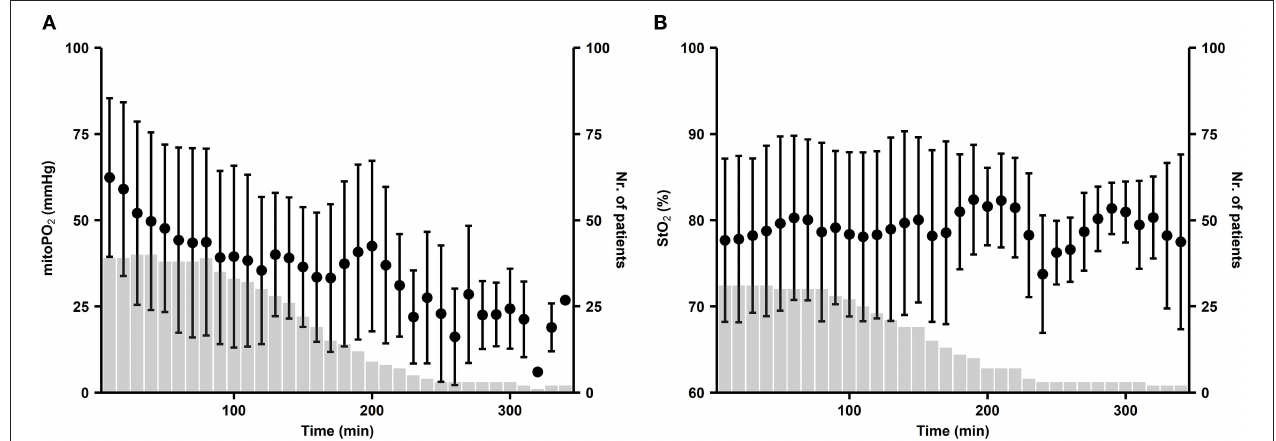
FIGURE 4 | (A) Distribution of cutaneous mitoPO 2 during CPB and (B) distribution of StO 2 during CPB, with the start of CPB at t = 0. Dots represent the mean value of patient-averaged cutaneous mitoPO 2 per 10-min window. Whiskers demonstrate the standard deviation. Bars represent the number of patients.